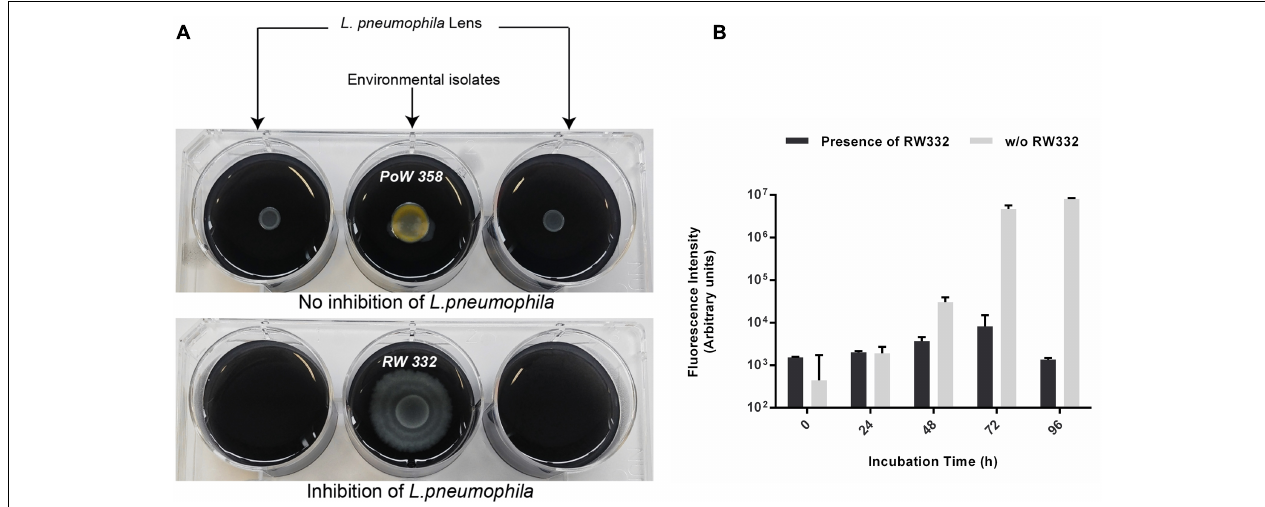
FIGURE 5 | Long distance way inhibition of GFP-expressing L. pneumophila through the production of volatile compounds produced by several Pseudomonas isolates. L. pneumophila was spread on both upper sides of the 6 wells plate. Each isolate was spread on the center of 6-well plates. (A) On the left microtiter plate, Pseudomonas PoW358 does not exhibit any anti- Legionella activity while on the right microtiter plate, Pseudomonas RW332 exhibits a volatile compounds-mediated growth inhibition. (B) Fluorescence quantification emitted by GFP-expressing L. pneumophila Lens in presence and absence of the strain RW332 ( n =